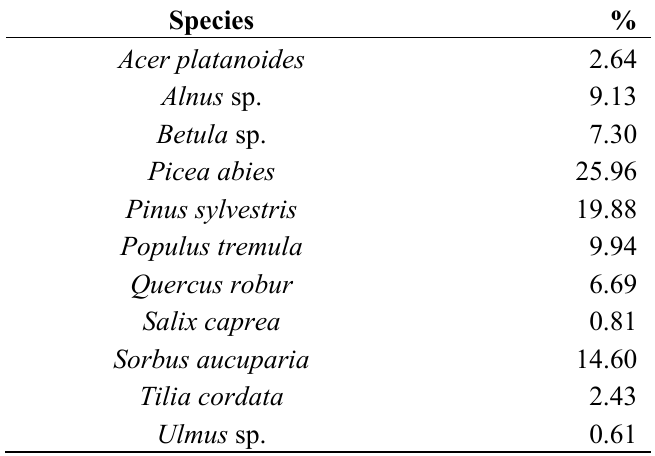
Table 1. Relative tree-species distribution in the study